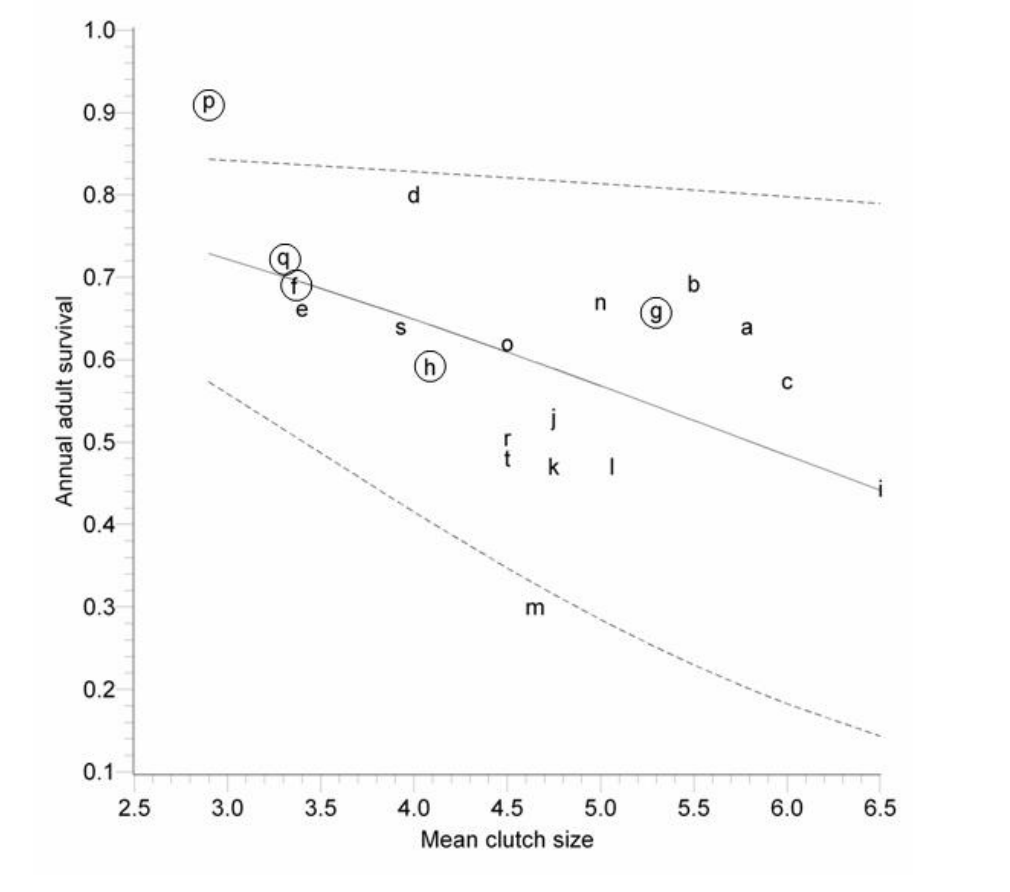
Fig. 3. Relationship between annual adult survival rates and mean clutch sizes of woodpecker species. The solid line indicates the mean, and the dashed lines indicate the 95% confidence limits of the regression line. The logit-transformed intercept and slope of the model were 1.97 ± 1.10 and -0.400 ± 0.178 (estimate ± 95% CI) , respectively. (a) Lesser Spotted Woodpecker ( Dendrocopos minor ), (b) Middle Spotted Woodpecker ( Dendrocopos medius ), (c) Great Spotted Woodpecker ( Dendrocopos major ), (d) White-backed Woodpecker ( Dendrocopos leucotos ), (e) Three-toed woodpecker ( Picoides tridactylus ), (f) Black Woodpecker (Mattsson and Christensen, unpublished data ), (g) Black Woodpecker (Rolstad et al. 1995), (h) Pileated Woodpecker (Bonar 2001), (i) Northern Flicker ( Colaptes auratus ), (j) Red-naped Sapsucker ( Sphyrapicus nuchalis ), (k) Red-bellied Sapsucker ( Melanerpes carolinus ), (l) Acorn Woodpecker ( Melanerpes formicivorus ), (m) Golden-fronted Woodpecker ( Melanerpes aurifrons ), (n) Red-bellied Woodpecker ( Melanerpes carolinus ), (o) Red- headed Woodpecker ( Melanerpes erythrocephalus ), (p) Red-cockaded Woodpecker (DeLotelle and Epting 1992), (q) Red-cockaded Woodpecker (Walters et al. 1988, Labranche and Walters 1994), (r) Downy Woodpecker ( Picoides pubescens ), (s) Hairy Woodpecker ( Picoides villosus ), (t) Nuttall’s Woodpecker ( Picoides nuttallii ). Circles indicate that the clutch size and survival rate were obtained from the same population. Otherwise, clutch sizes were obtained from Winkler et al. (1995), and survival rates were obtained from Pasinelli (2006) and Wiebe (2006) for European (a–g) and North American (h–t) species,